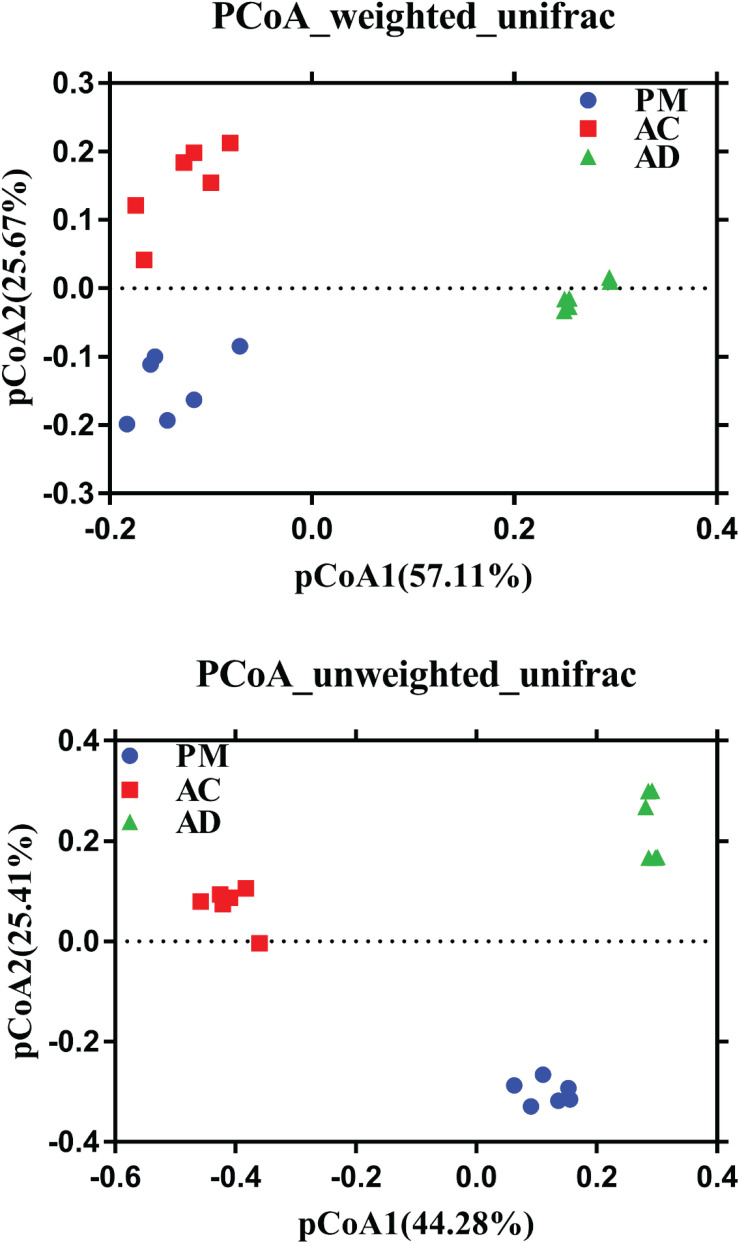
Principal coordinate analysis (PCoA) using weighted and unweighted UniFrac community distances between among three group samples. PM, swine manure samples; AC, aerobic composting samples; AD, anaerobic digestion samples.